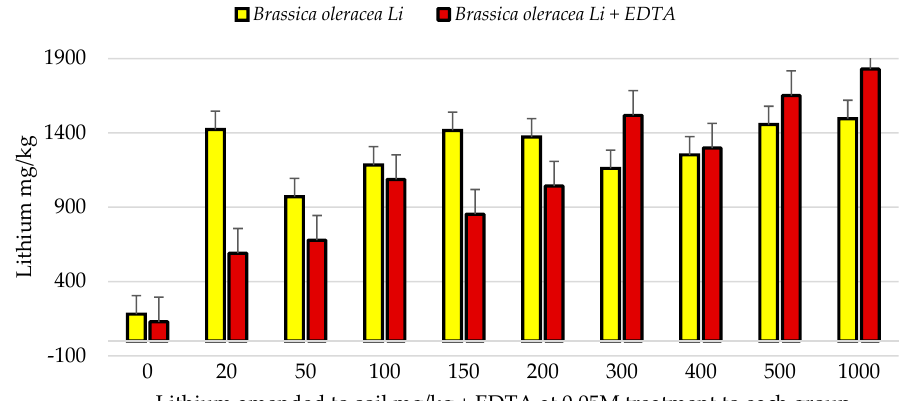
Figure 3. x ̅ Li concentration in leaves of Brassica napus from trial 1 (no chelator) and Brassica napus from trial 2 (EDTA treatments at 0.05 M). X-axis, concentration of Li amended to the soil. (Units = mg/kg).